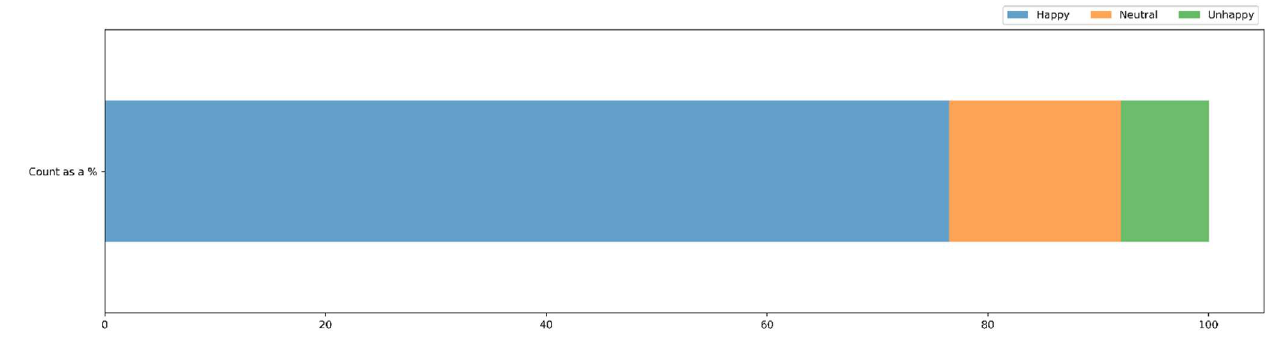
Figure 9. Percentages of the satisfaction data.